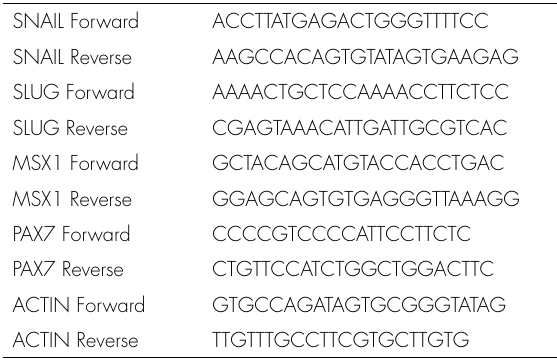
Table II. Sense and antisense primer